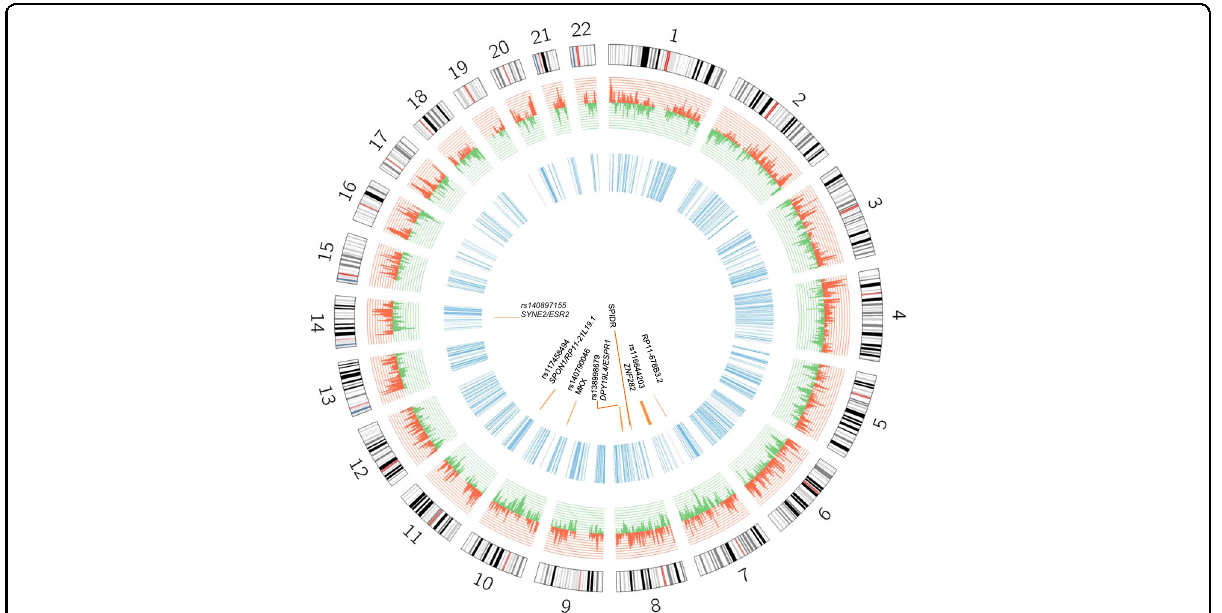
Fig. 3 Circos plot for the prioritized regions. Histogram for the effect of the 21,190 consensus ROHs identi fi ed in the whole sample is shown. Risk ROH associations are shown in red; protective ROH associations are shown in green. Blue regions represent prioritized ROHs from consanguineous AD cases. Orange segments represent prioritized regions harboring potential recessive